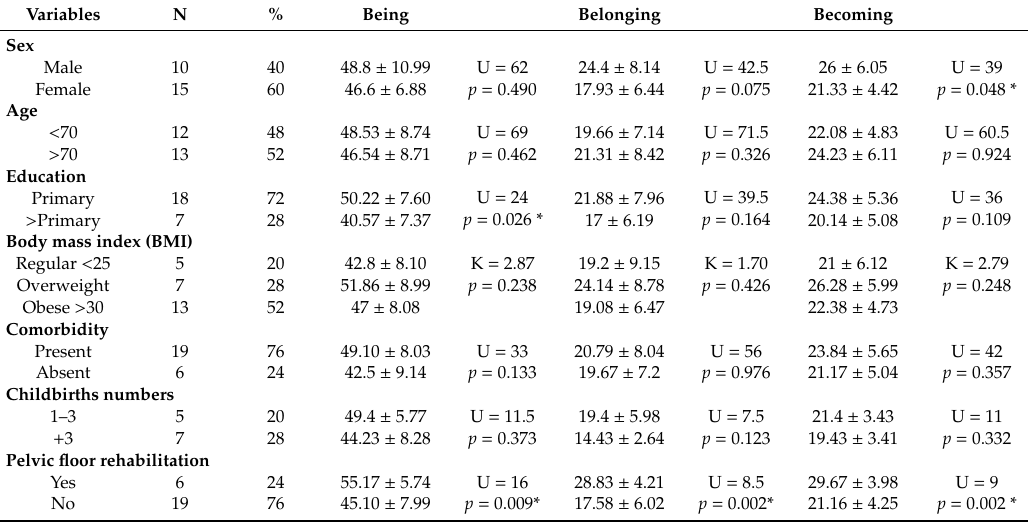
Table 6. ThistableshowsthemeanscorecomparisonbetweenQOLdomains, basedonsocio-demographic and clinic